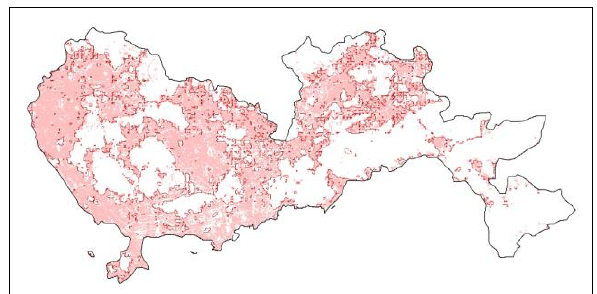
Figure 9. Luojia 1-01